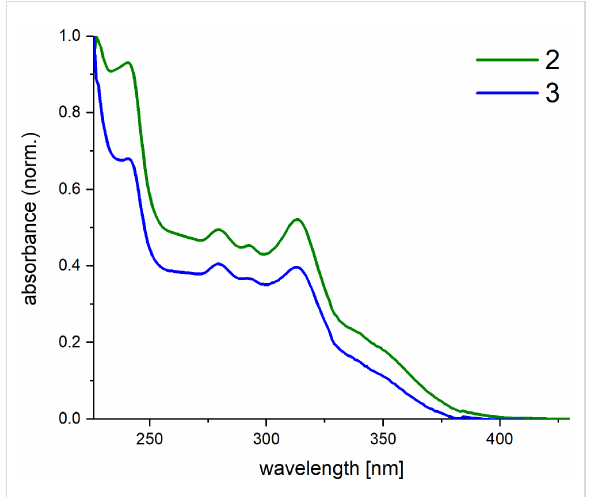
Figure 2: UV–vis absorption spectra of complexes 2 and 3 measured in dichloromethane at room temperature.